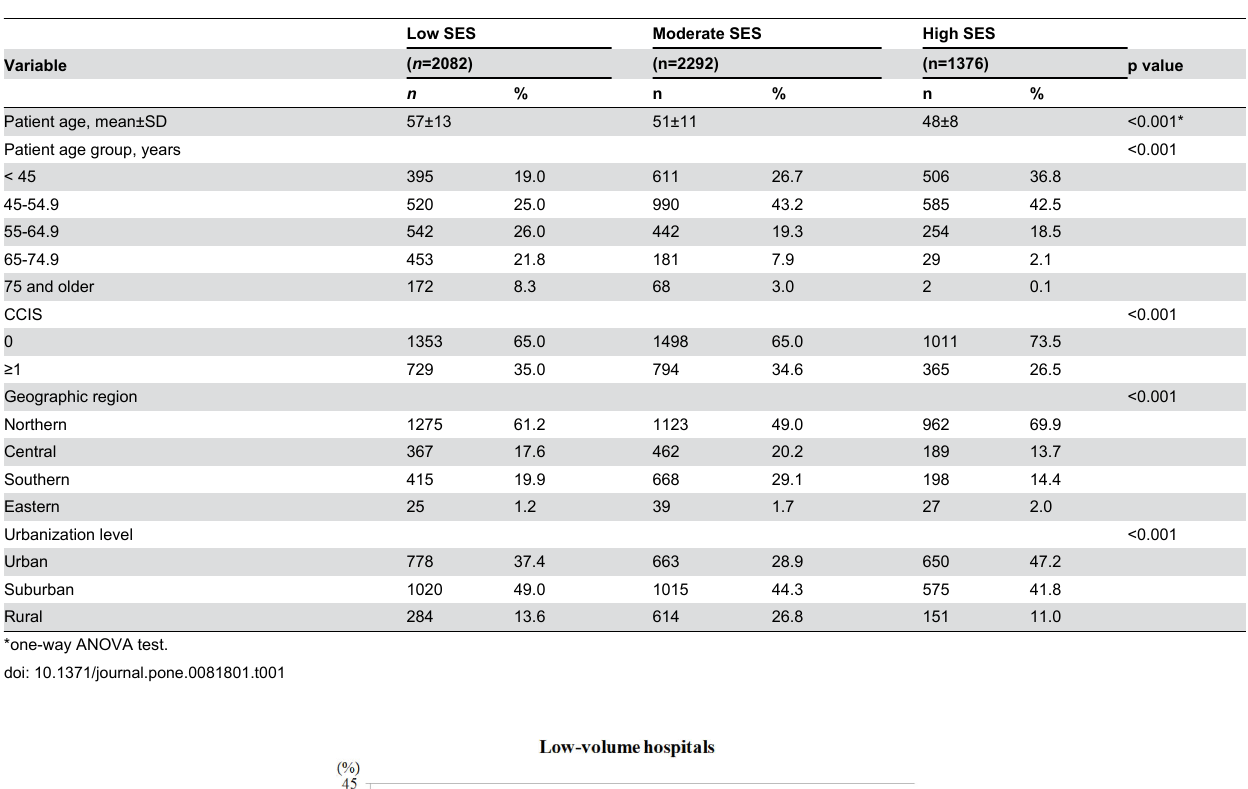
Table 1. Baseline characteristics ( n =5750).